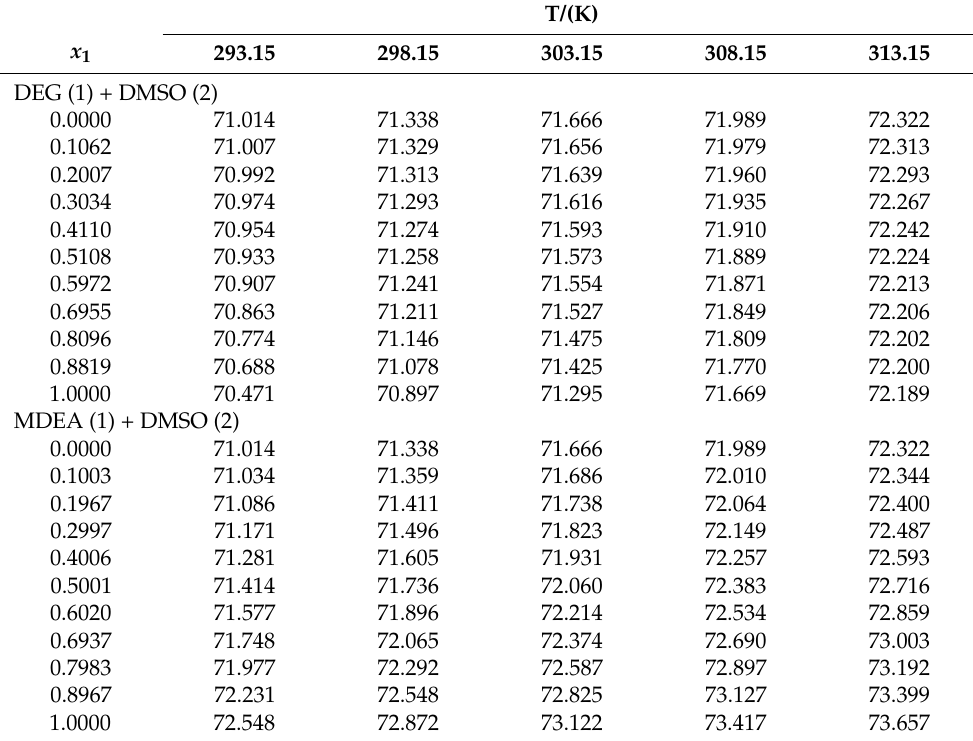
Table A8. Partial molar volumes V 2 (cm 3 · mol − 1 ) for binary systems in the temperature range from 293.15 to 313.15